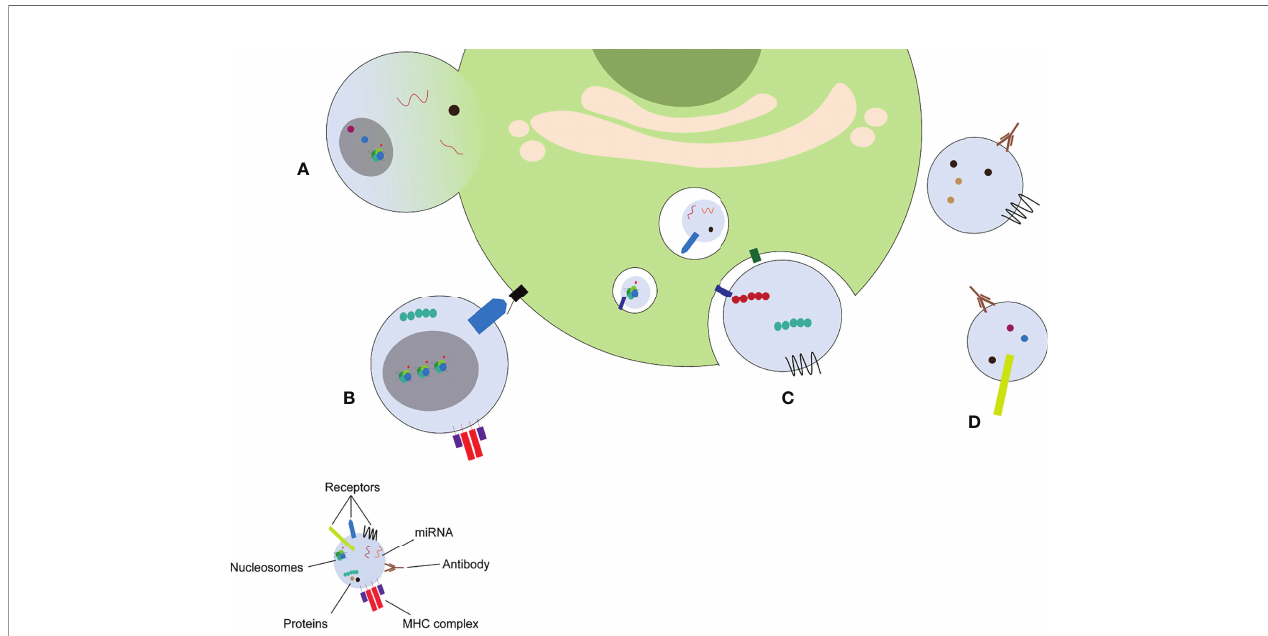
FIGURE 3 | MP induce cellular response via different mechanisms. MPs can fuse with the target cell (A) , stimulate receptors on the target cell by direct binding (B) , release their content into the endosomal compartment (C) , or form immune complexes with autoantibodies (D) . miRNA: microRNA, MHC: major histocompatibility